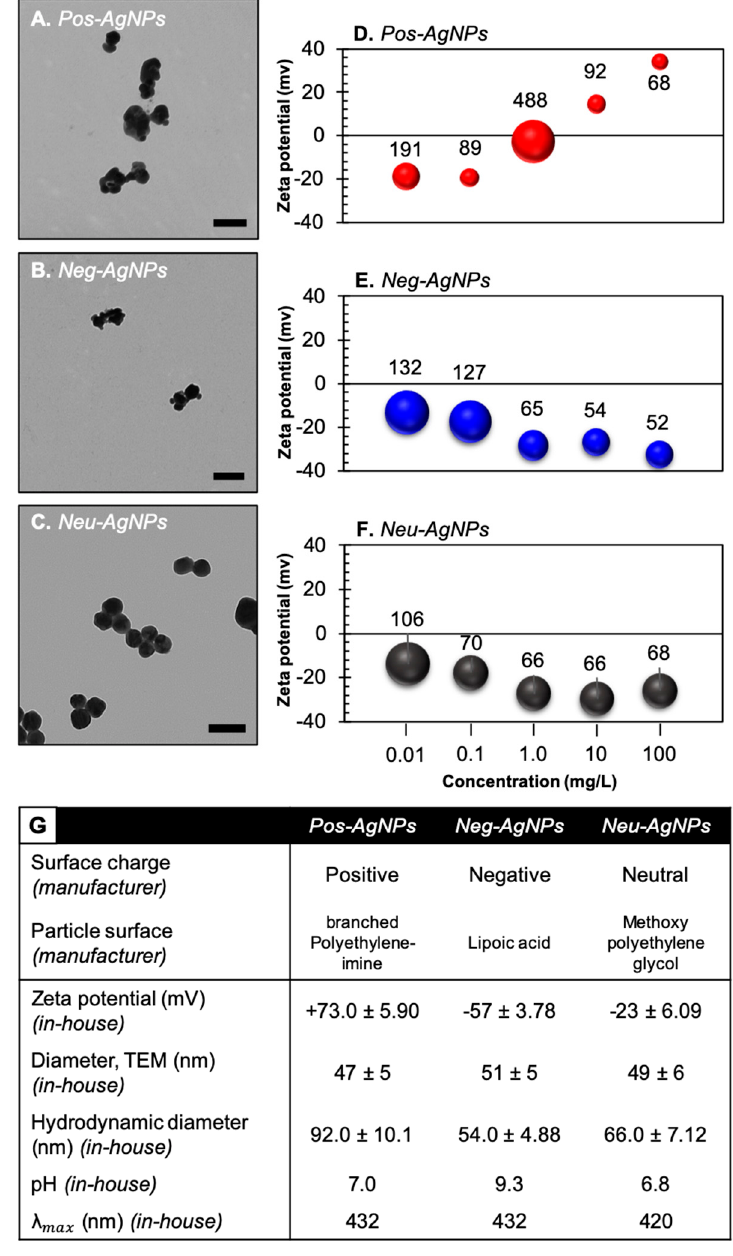
Figure 2. AgNP physicochemical characterization before incubation. Representative TEM images of ( A ) Pos–AgNPs, ( B ) Neg–AgNPs, and ( C ) Neu–AgNPs used in this study. Scale bar indicates 50 nm. Changes in zeta potential measurements (indicated by data point) and hydrodynamic diameter (indicated by value above data point) over increasing nanoparticle concentrations in ultrapure water for ( D ) Pos–AgNPs, ( E ) Neg–AgNPs, and ( F ) Neu–AgNPs used in this study. ( G ) Table of properties measured in-house or provided by nanoparticle manufacturer .